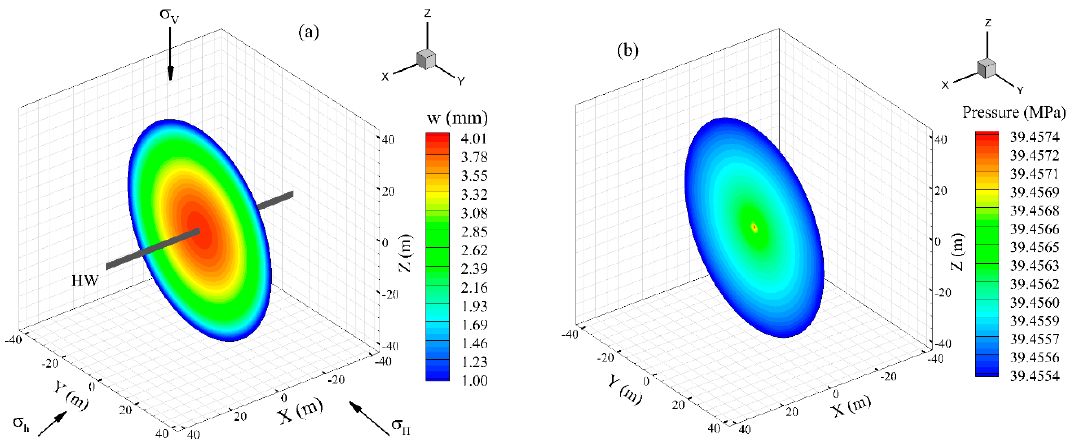
Figure 3. ( a ) Distribution of fracture aperture, ( b ) distribution of the fluid pressure after 1300 (s) of injection (fluid injection rate = 0.01 m 3 / s, fluid viscosity = 0.001 Pa.s, fracture toughness = 10 MPa.m 0.5 ).